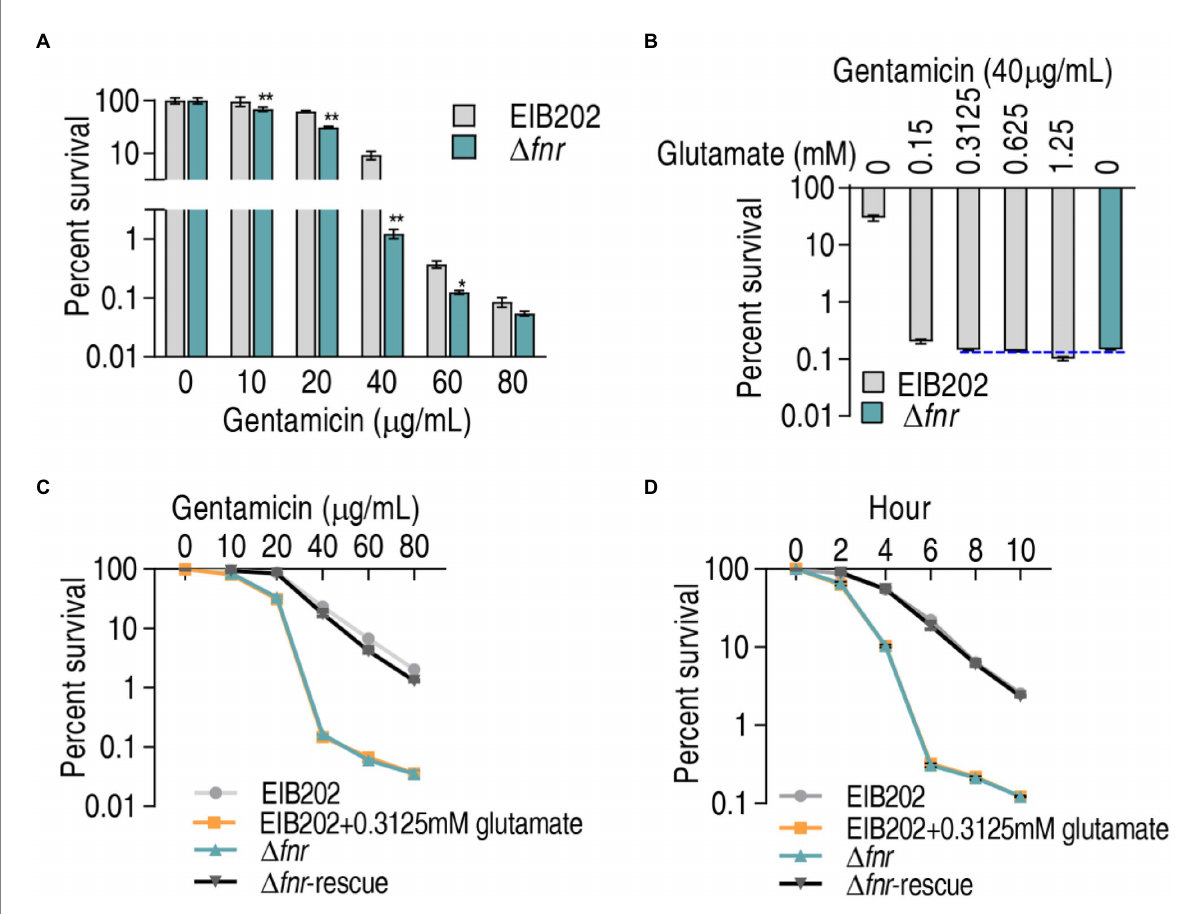
FIGURE 6 Exogenous glutamate elevates sensitivity of EIB202 to gentamicin. (A) Percent survival of EIB202 and Δ fnr in the indicated concentration of gentamicin. (B) Percent survival of EIB202 and Δ fnr in the indicated concentration of glutamate plus 40 μ g/ml gentamicin. (C) Percent survival of EIB202 and Δ fnr in the indicated concentration of gentamicin plus 0.3125 mM glutamate. (D) Percent survival of EIB202 and Δ fnr in the indicated times with 0.3125 mM glutamate plus 40 μ g/ml gentamicin. Results are displayed as means ± SEM, and significant differences are identified (* p < 0.05; ** p < 0.01) as determined by Student’s t -test. At least three biological repeats were carried